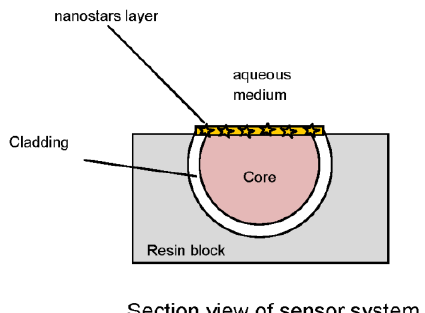
Figure 3. Optical sensor system based on LSPR in